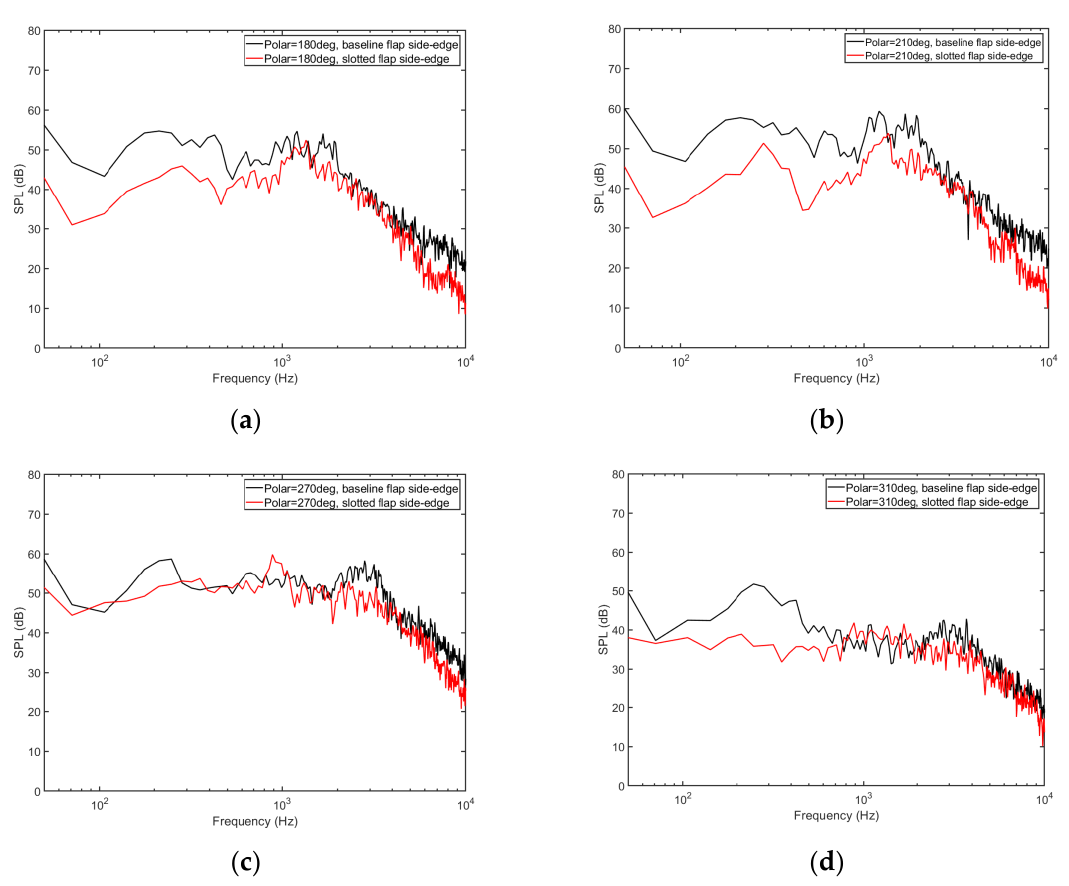
Figure 16. Noise comparison between the baseline flap side-edge and slotted flap side-edge. ( a ) Polar angle of 180 degrees; ( b ) polar angle of 210 degrees; ( c ) polar angle of 270 degrees; ( d ) polar angle of 310 degrees.